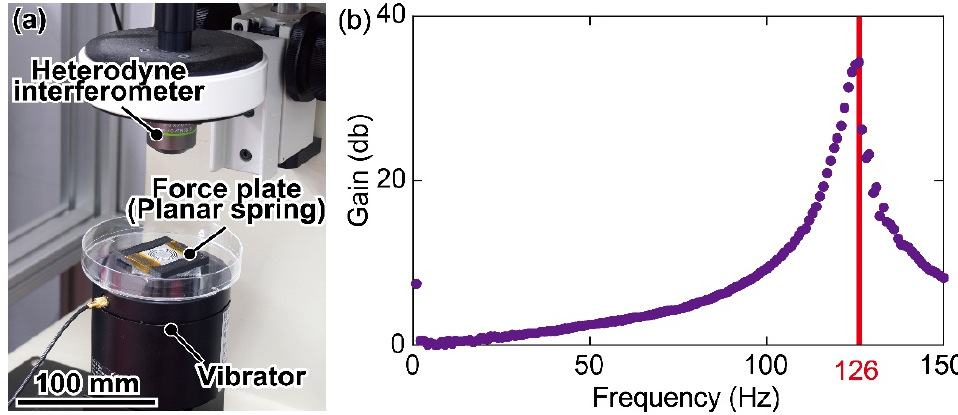
Figure 8. ( a ) Photograph of the experimental setup to evaluate the resonant frequency of planar spring. ( b ) Frequency response of the planar spring. spring. ( b ) Frequency response of the planar